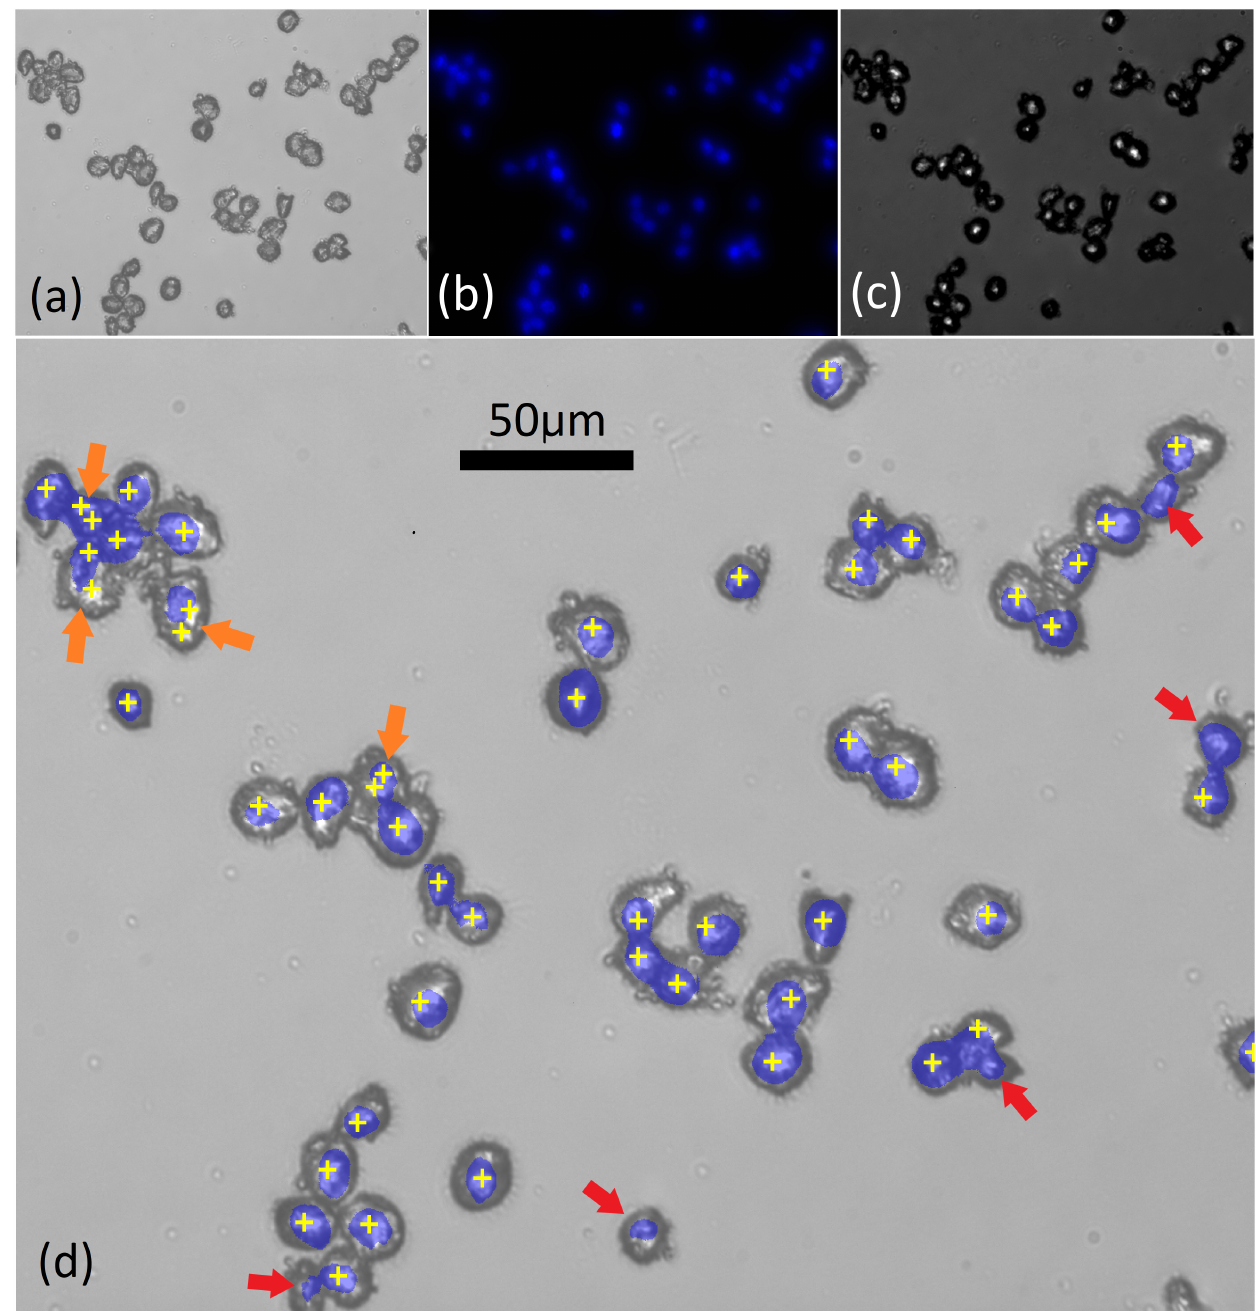
Figure 2. HeLa cells on ThinPrep slides: ( a ) bright-field image; ( b ) fluorescence image using DAPI; ( c ) bright-spot image: sample at 14 µ m from focal plane; ( d ) combined images. Images ( a , b ) are superimposed together with the positions of the local maxima in image ( c ) following image processing. The arrows are described in the